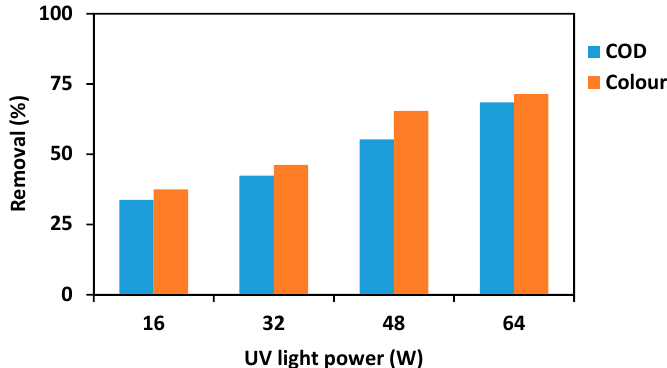
Figure 4. Effect of UV light irradiation power on photocatalytic degradation (process conditions: pH—4, reaction time—3 h, TiO 2 dosage—500 mg/L).